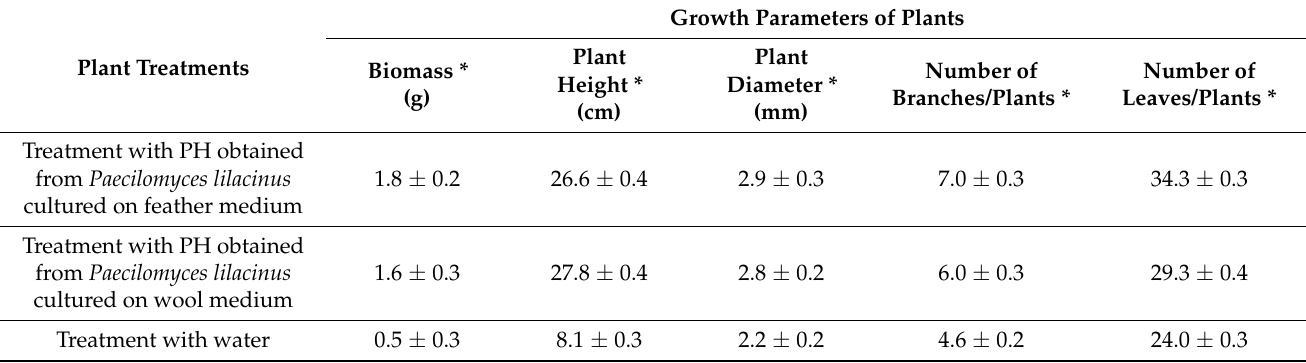
Table 3. Evaluation of treatment effects applied to tomato